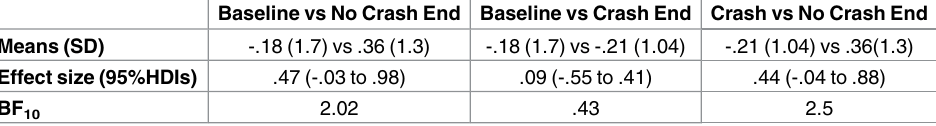
Table 2. Effect sizes with their corresponding 95% HDIs and BayesFactor values, of the comparisons between the mean amplitudes in the three